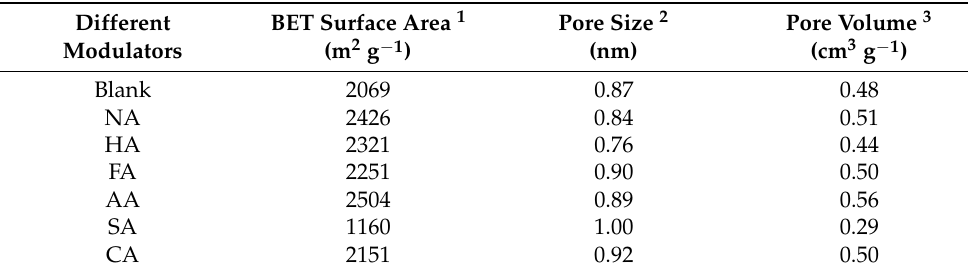
Table 1. Specific surface area, pore size, and pore volume of the blank sample and MIL-101 (Cr, Sn) with different modulators as an additive.